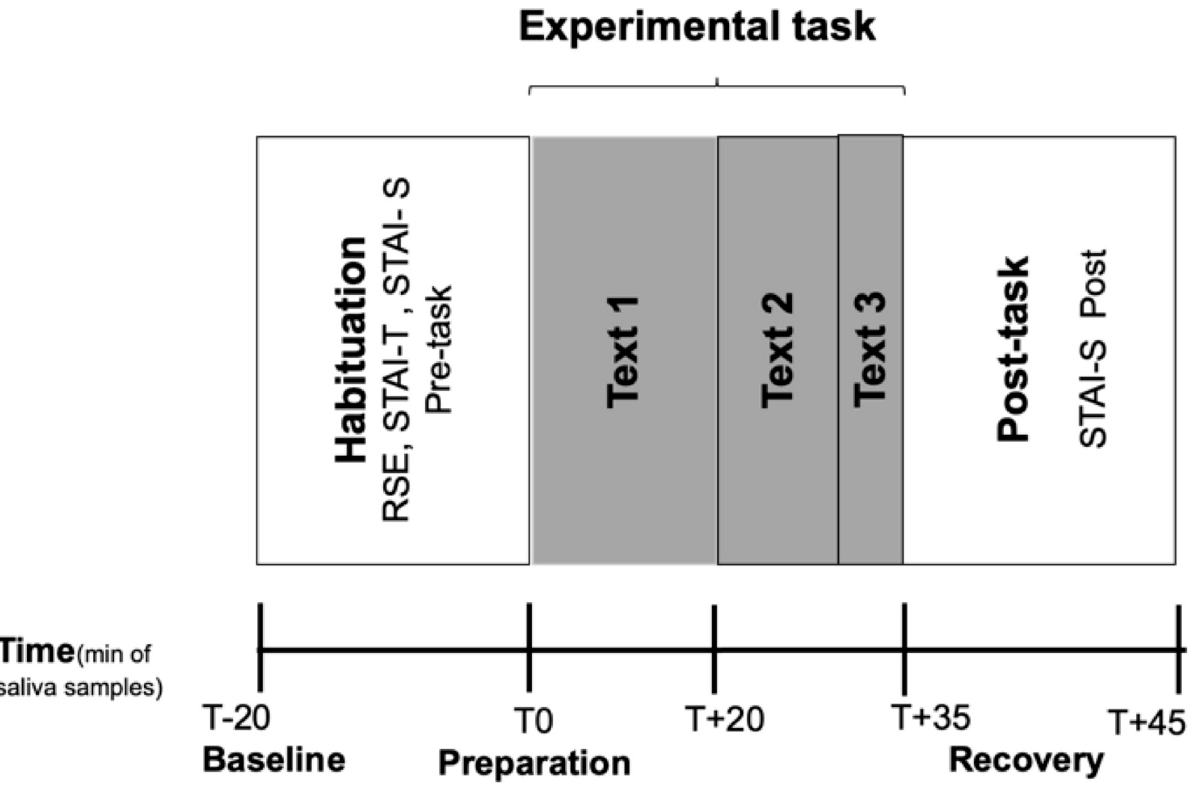
Fig 1. Different phases of the experimental